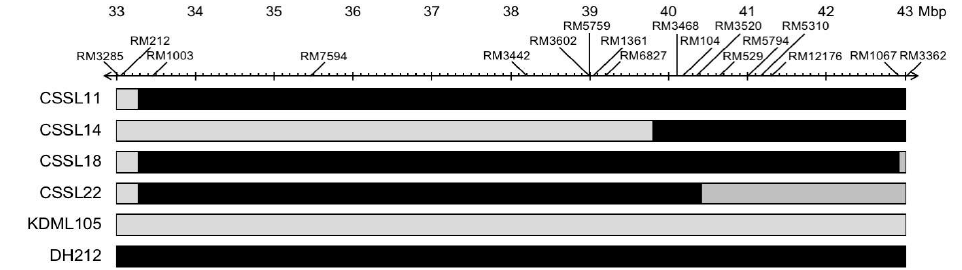
Figure 1. Simple sequence repeat (SSR) markers in the salt-tolerant quantitative trait locus (QTL) region [5] of the rice lines used in this study. Black indicates the genomic DNA from DH212, the donor parent, and the gray indicates the genomic DNA from ‘KDML105’, the recurrent parent. The chromosome substitution lines (CSSLs) were checked with SSR markers in other regions of the genome and >95% were in the ‘KDML105’ genome .